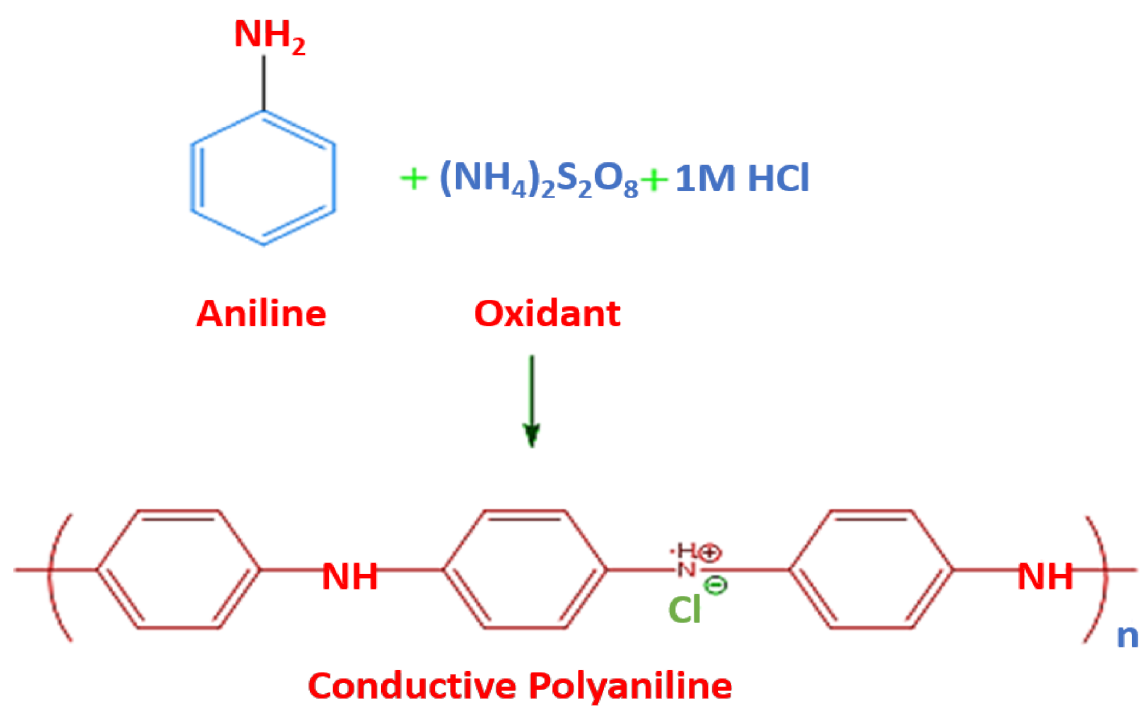
Figure 7. Numerous applications and properties of conducting polymers. Reproduced with permission from